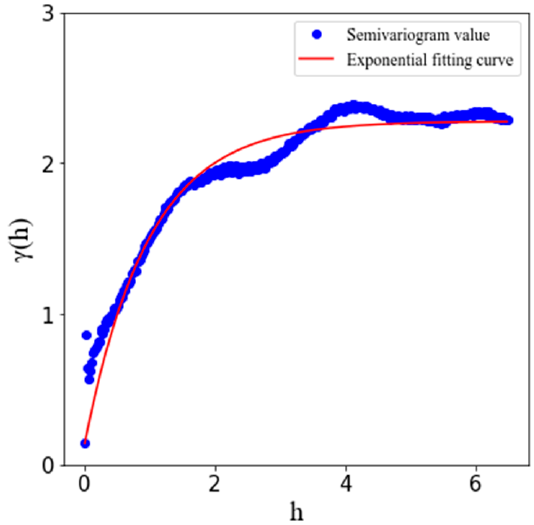
Figure 3. The semivariogram value and exponential fitting curve. After the initial seed points are determined, the region growing process from the seed point with the largest comprehensive plane feature strength is used to determine the segmentation area where this seed point is located. If the angle between the normal vector of the neighboring point and the seed point is less than the threshold θ th , the neighboring point will be merged into the segmentation area. At the same time, the curvature of the neighboring point is calculated. If the curvature is less than the curvature threshold c th , the neighboring point is used as the next seed point of the segmented region to continue the region growing process, otherwise the point is ignored. The above process will be repeated until the area reaches the maximum value. Once this segmented area is determined, the region growing process is proceeded from the next initial seed point to repeat the above process until all initial seed points are processed. The angle threshold θ th of normal vector is an empirical value selected based on the calculation results, and the curvature threshold c th is 95% of the curvature value of each point in the point cloud after sorting in ascending order [46]. The purpose of using threshold in this paper is to keep a balance between over-segmentation and under-segmentation. Finally, all the leaf areas are saved, including the individual leaf point clouds that has been segmented and the overlapping leaf point clouds that need further